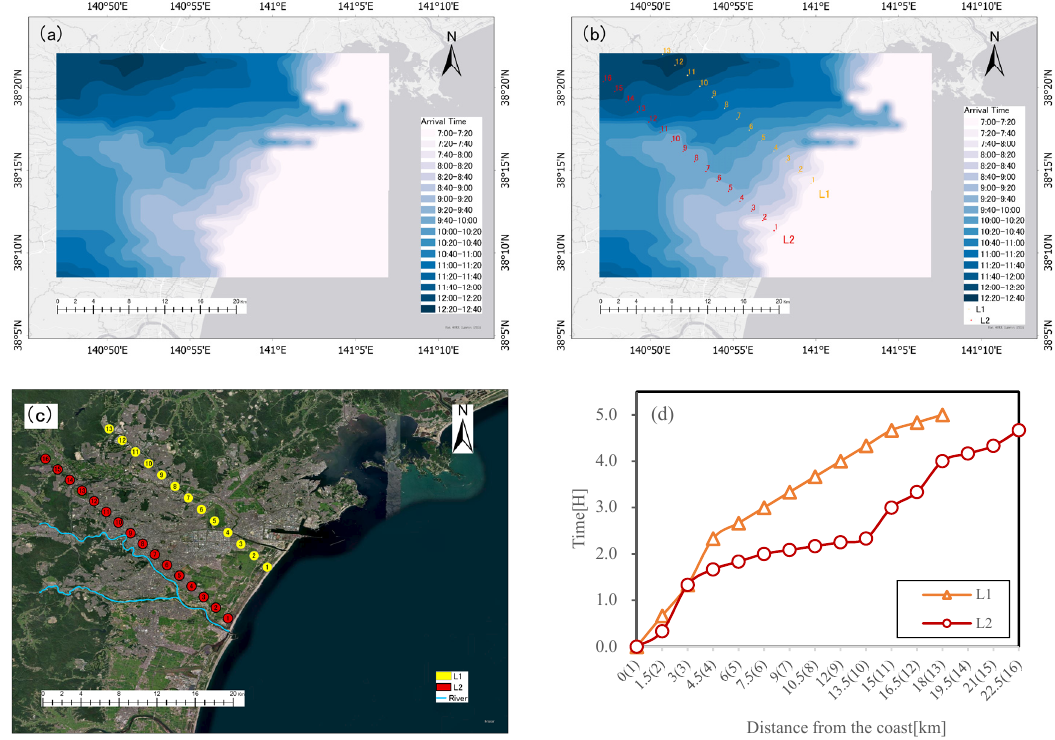
Figure 11. ( a ) Sea breeze arrival time map; ( b ) distribution of points in the L1 and L2 directions on the sea breeze arrival time map; ( c ) distribution of points in the L1 and L2 directions on the satellite map; ( d ) arrival times of points in the L1 and L2 directions.